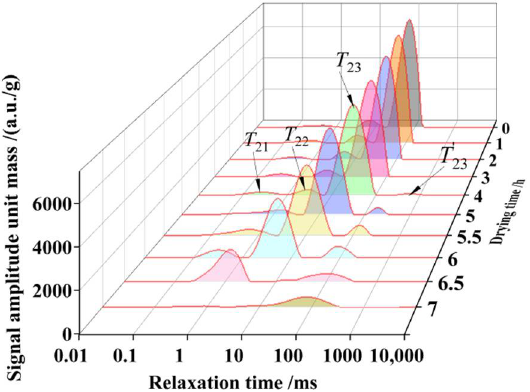
Figure 5. LF-NMR transverse relaxation time spectra of soybean dregs with different moisture con-